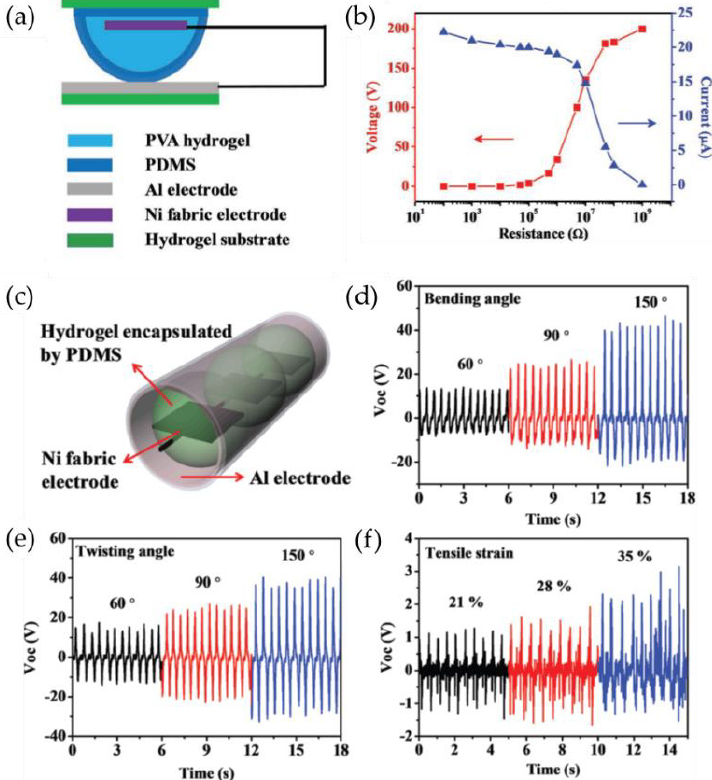
Figure 4. ( a ) Schematic of the hydrogel-based triboelectric generator. ( b ) Output voltage and current versus the resistance of the external loads. ( c ) Schematic diagram of the Hydrogel-TENG in a tube shape, along with the open-circuit voltage generated by ( d ) bending, ( e ) twisting, and ( f ) tensile strains. (Reprinted with permission from